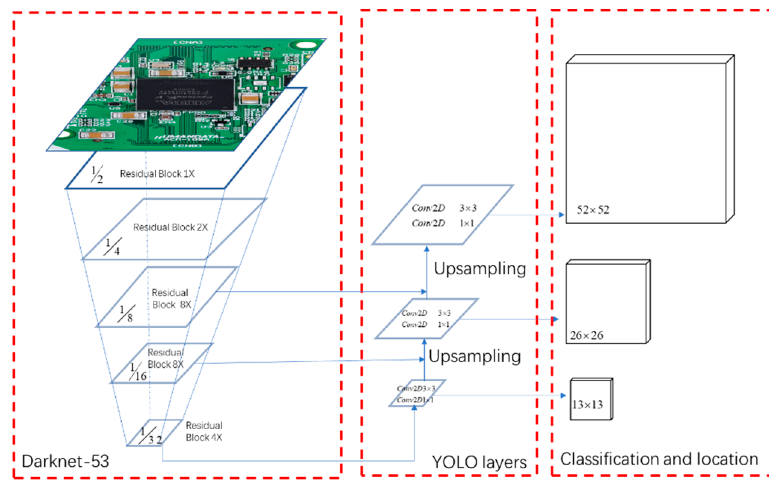
Figure 2. Schematic of the YOLO V3 network architecture.